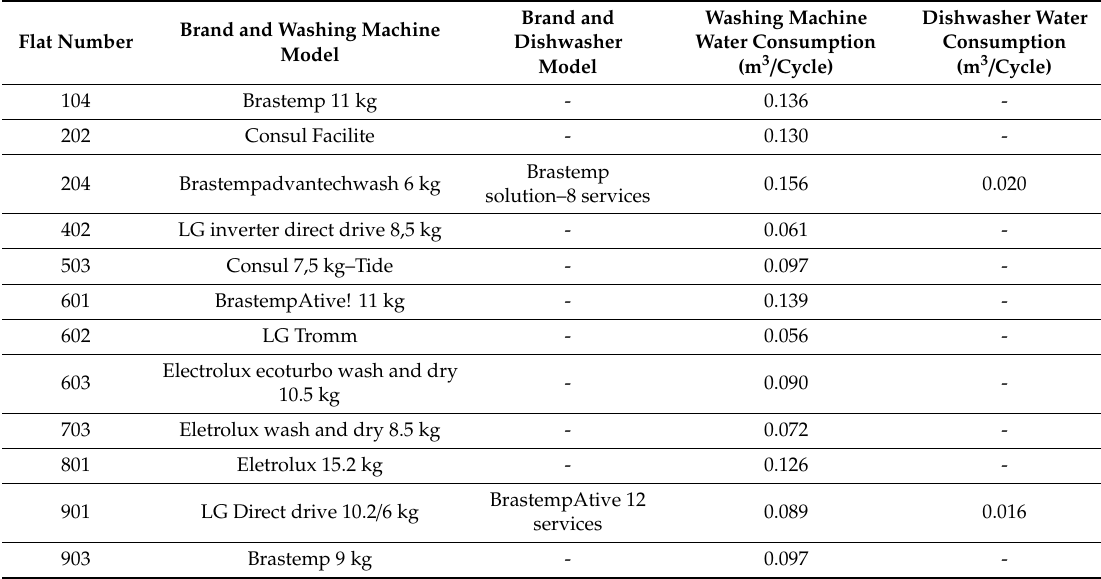
Table 2. Water consumption in washing machines and dishwashers which were used during monitoring in